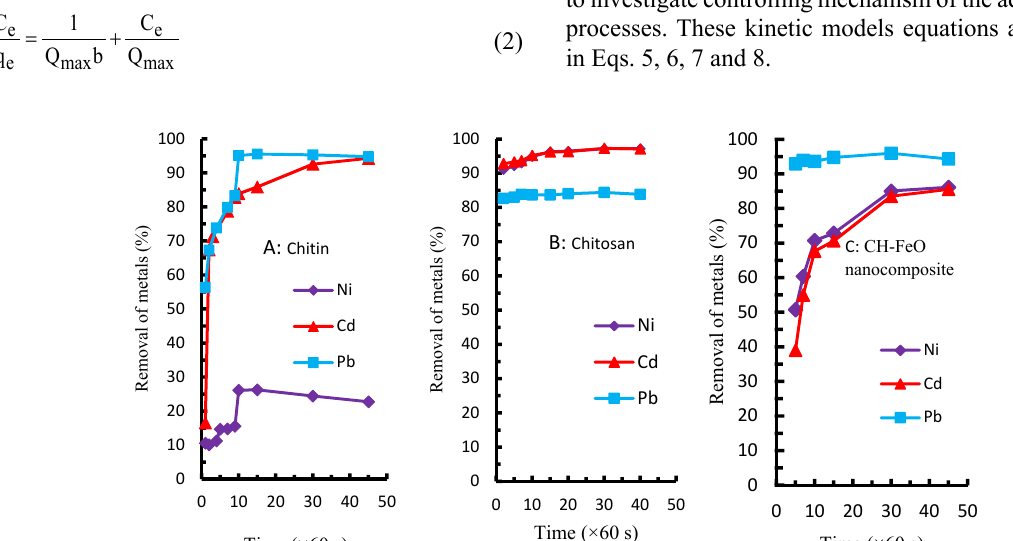
Fig. 7: Heavy metal adsorption versus changing contact time of A) Chitin 0.15 g, B) Chitosan 0.15 g and C) CH-FeO nanocomposite 0.05 g. The experiment conditions: 20 dm 3 solution, initial ion concentrations 10 mg/dm 3 , the mixing speed 5 rps, pH=3, room temperature.